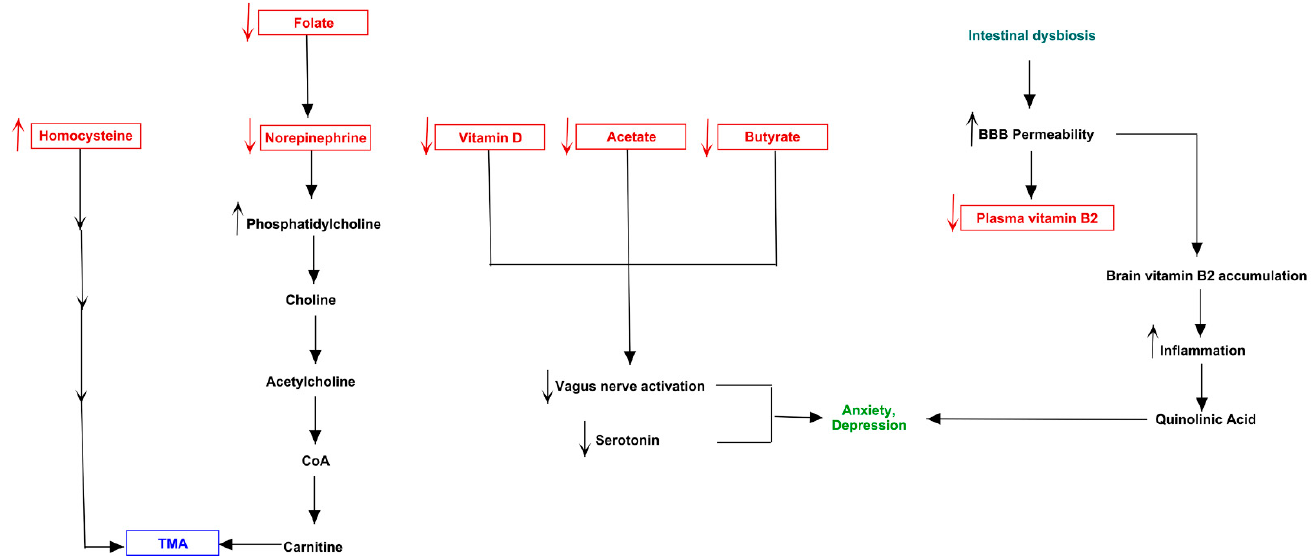
Figure 10. Biochemical pictures of TMAU patient 4. The panel represents how metabolites produced directly or indirectly by patient’s microbiota could influence the biosynthesis/release of neurotransmitters (in particular serotonin) and the production/accumulation of TMA.